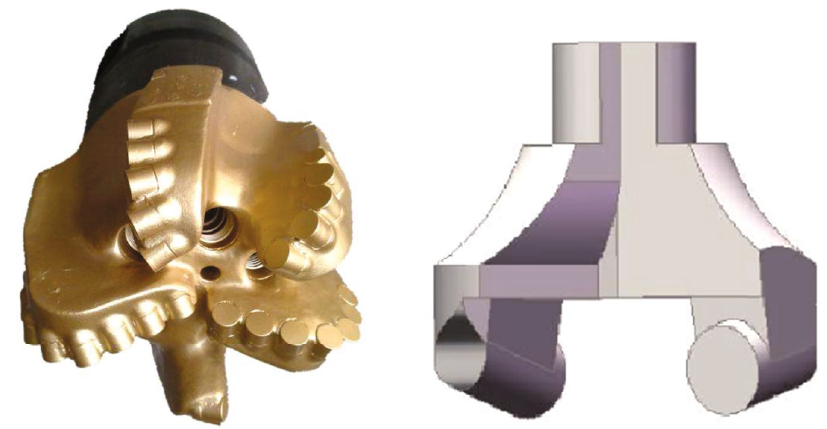
Figure 3: Simpli fi ed model of PDC bit with double cutting